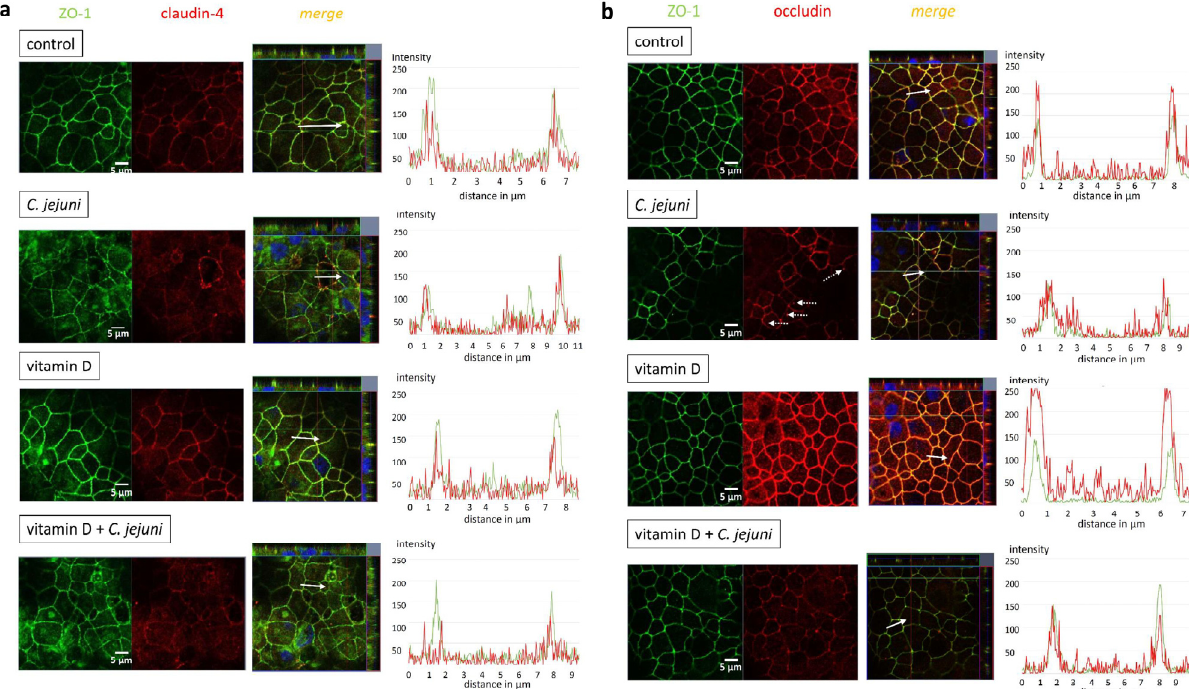
Figure 5. C. jejuni -induced redistribution of tight junction proteins is prevented by vitamin D treatment in vitro. C. jejuni -infected HT-29/B6-GR/MR cells were treated with 200 nM vitamin D. 48 h after infection with C. jejuni , cells were stained with antibodies to ZO-1 (green) and ( a ) claudin-4 (red) or ( b ) occludin (red), and visualized by confocal laser-scanning microscopy. Nuclei were stained blue with 4 ′ ,6-diamidino-2-phenylindole (DAPI) (bar 5 µm). Co-localization of the TJ proteins is depicted by a yellow merge signal. White arrows in the z-stacks indicate the analyzed area of the displayed intensity distance plot. Intensity distance plots indicate changes in the signal intensity on the abscissa, and redistribution to intracellular regions on the ordinate.